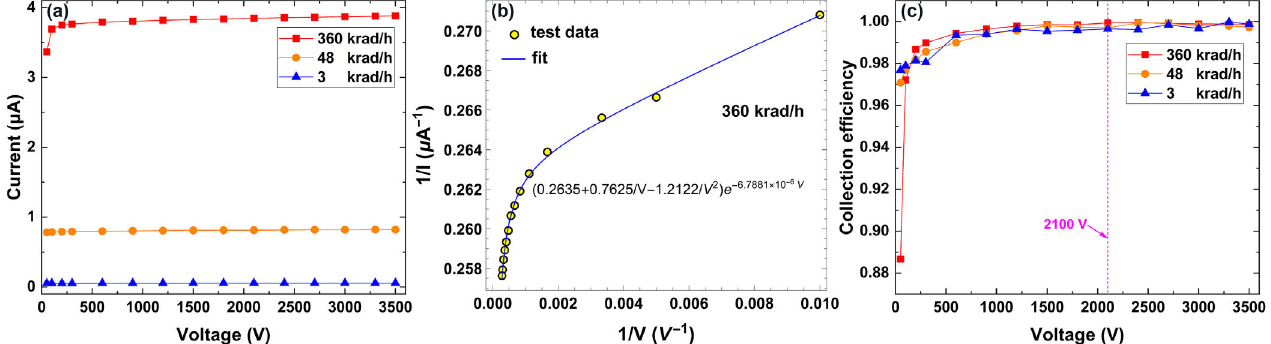
FIG. 8. (a) The test data of plateau curve, (b) the data fit, and (c) deduced collection efficiency of a BLM using a 60 Co radioactive source. The dose rates are respectively 360, 48, and 3 krad =